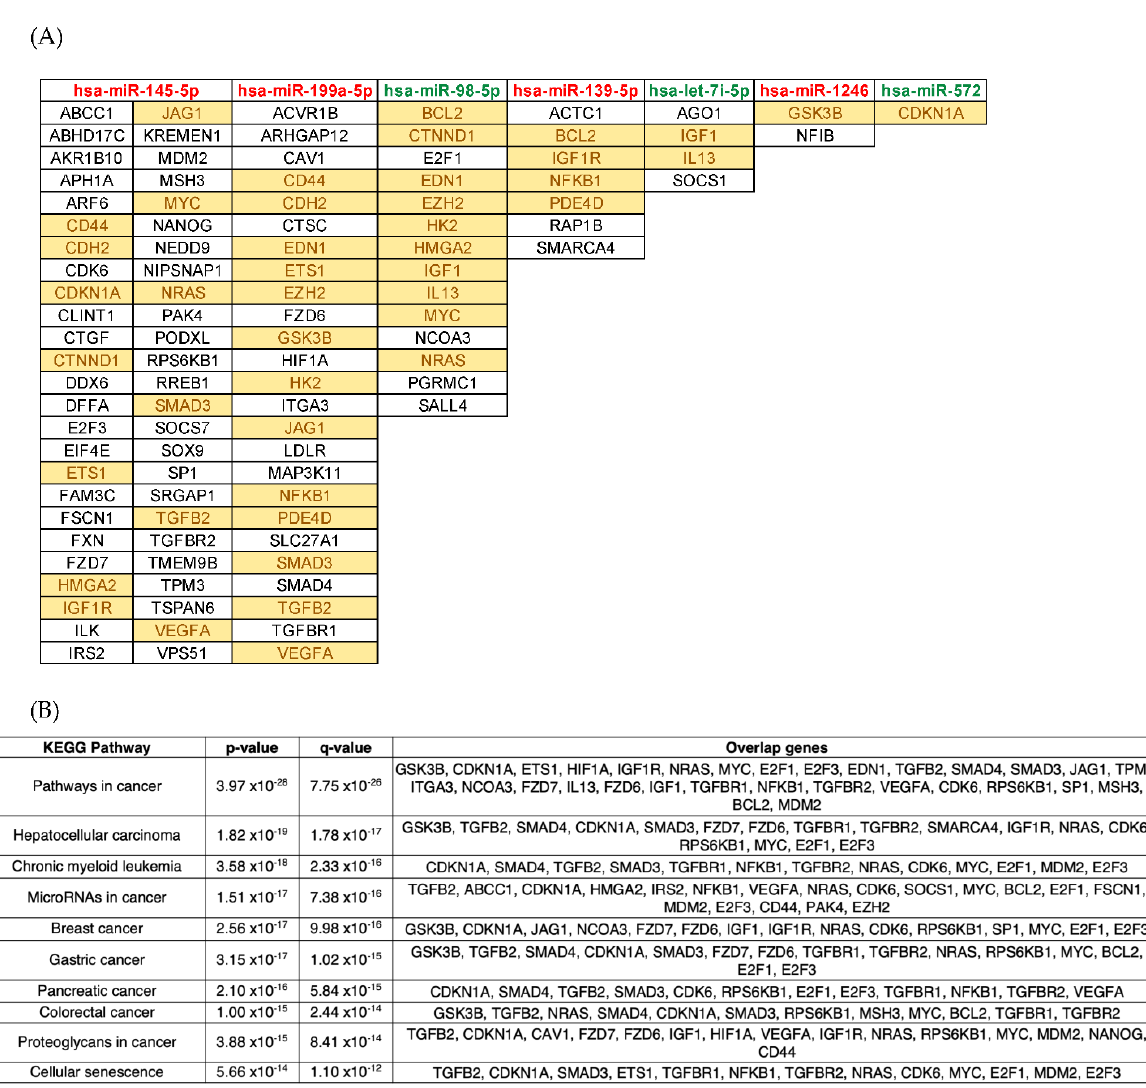
7 of 16 Figure 1. Differential expression analysis of miRNAs and snoRNAs in asymptomatic, mild, and severe COVID-19 patients. ( A ) A Venn diagram of the number of unique and common differentially expressed miRNAs and snoRNAs in severe versus asymptomatic (D: grey: upregulated, A: orange: downregulated), and in severe versus mild (C: purple: upregu- lated, B: green: downregulated). The overlap of the two ovals with upregulated transcripts represents 7 miRNAs and snoRNAs shared between the two upregulated lists, and the two ovals with downregulated transcripts represent 1 miRNA shared between the two downregulated lists. The areas of no overlap represent the number of uniquely (not shared) miR- NAs/snoRNAs in each respective comparison, namely 4 in severe versus asymptomatic, and 23 miRNAs/snoRNAs in severe versus mild comparison. ( B ) Volcano plots of differentially expressed miRNAs and snoRNAs, with y-axis as-log 10